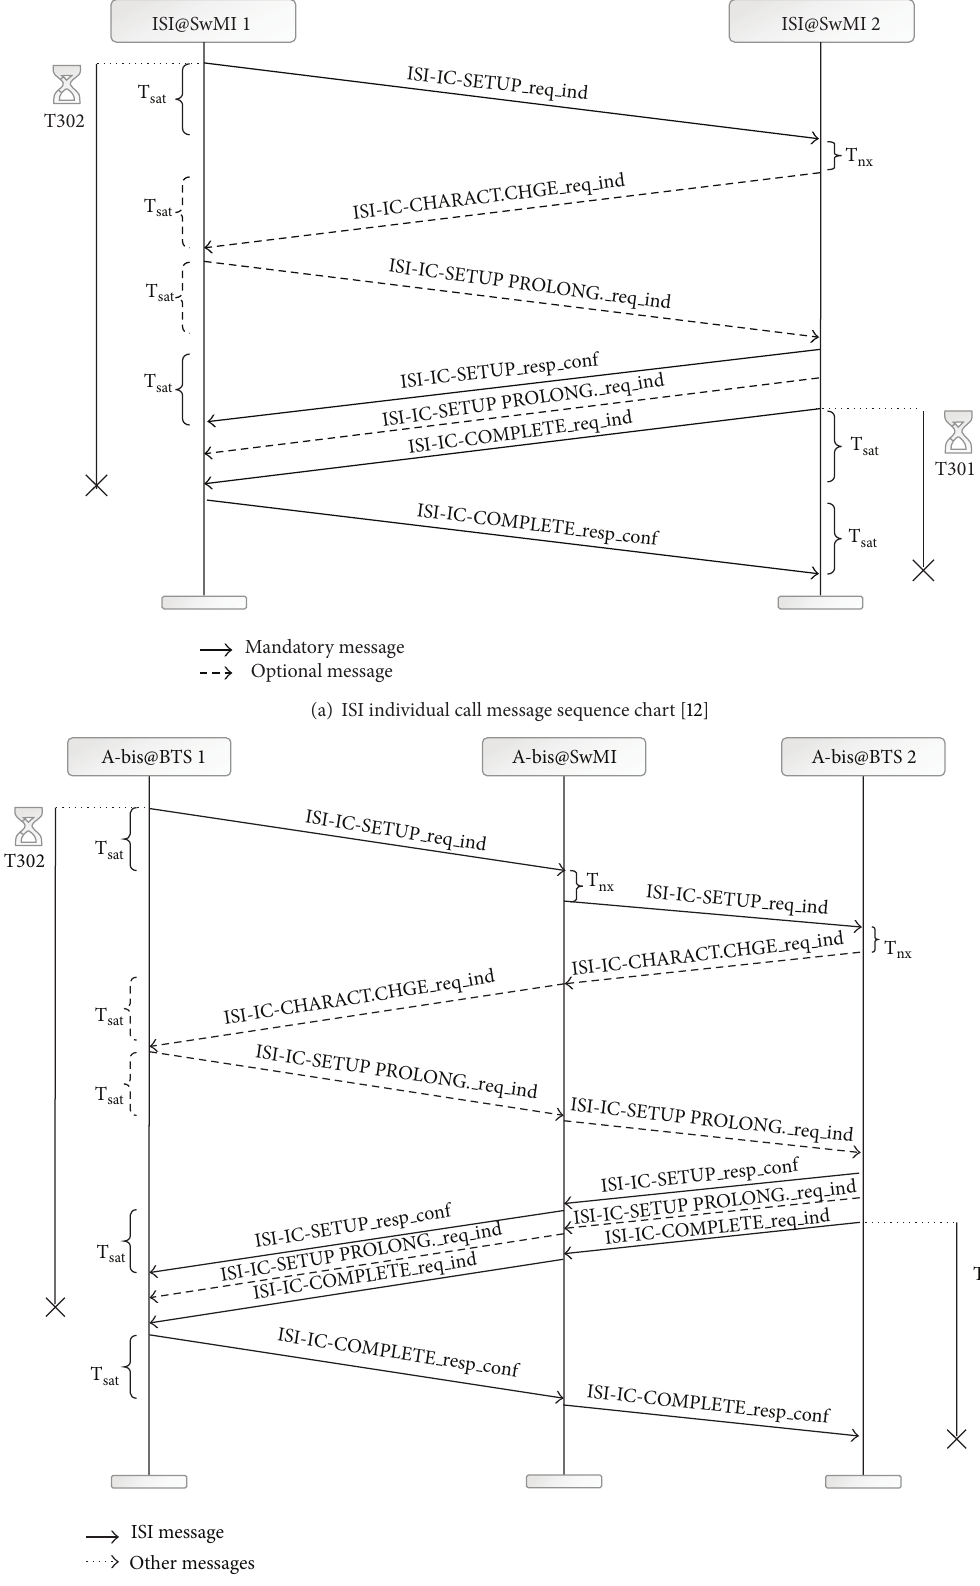
Figure 4: Successful individual call setup for ISI and A-bis